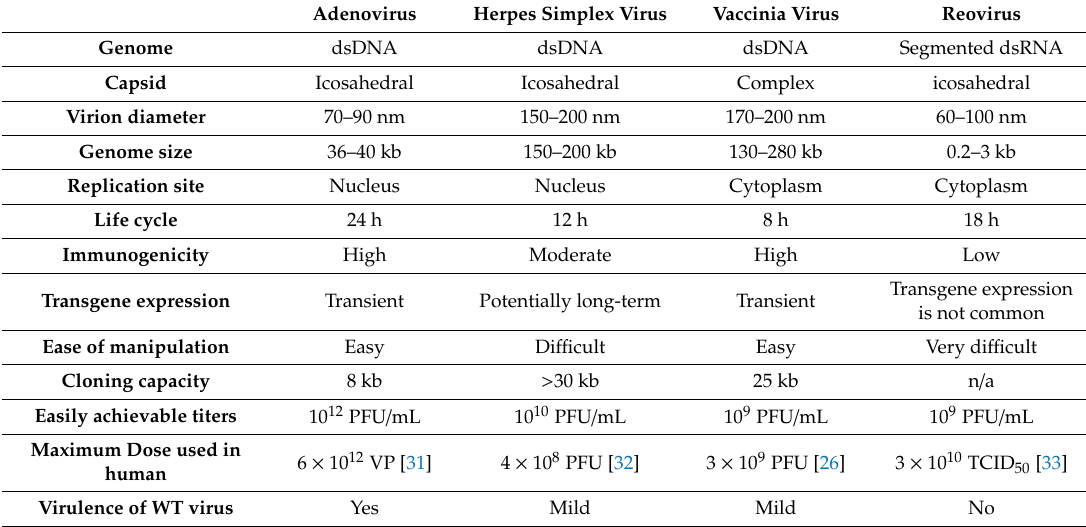
Table 1. Comparison of oncolytic virus